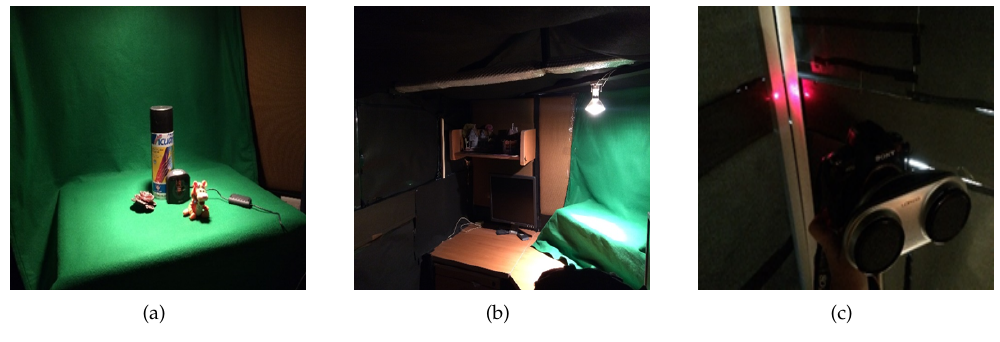
Figure 9. The design of the dark room: ( a ) Scenario, ( b ) stage with background and ( c ) laser calibrition of LOREO